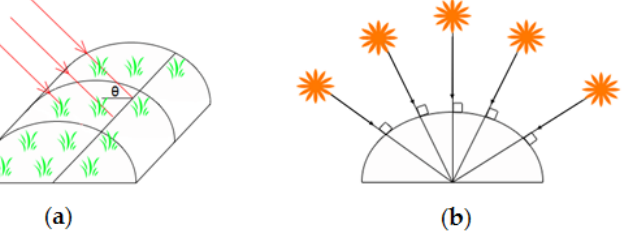
Figure 3. ( a ) Sunrays incident upon a Quonset-type greenhouse. ( b ) Sunray is assumed to be perpendicular to the Quonset-type surface.